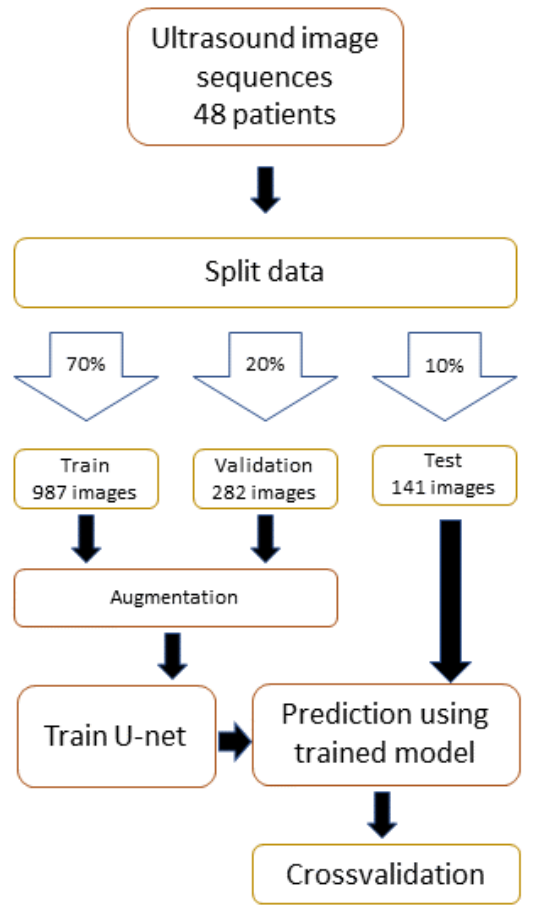
Figure 2. Flow chart of the data-handling and model-training process.